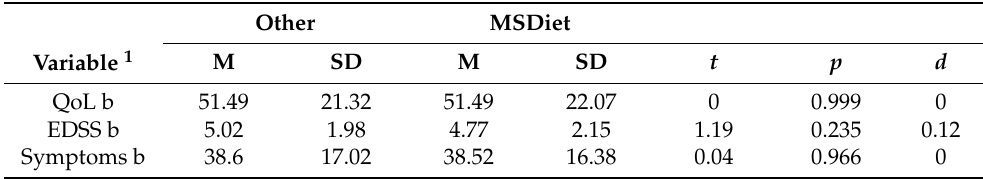
Table 7. Two-tailed independent samples t -test for QoL, EDSS, and Symptoms at baseline MS-